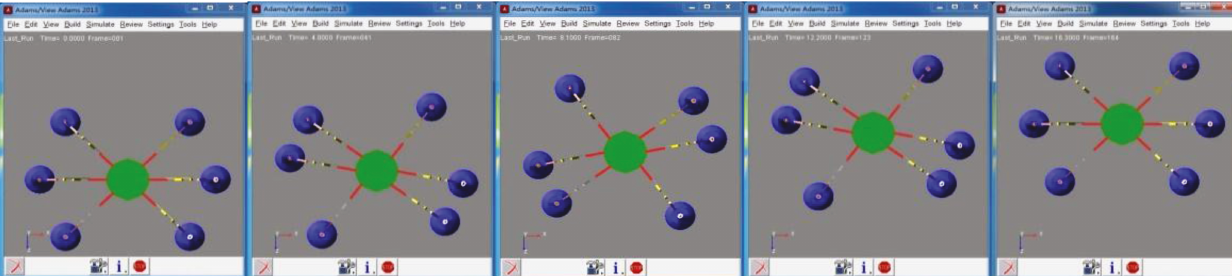
Figure 14: Motion simulation of the wall-climbing hexapod robot in triangular gait.